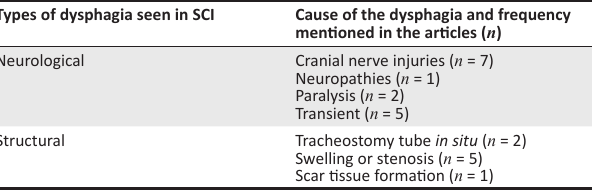
mentioned in the articles ( n ) Neuropathies ( n = 1) Paralysis ( n = 2) Transient ( n = 5) Swelling or stenosis ( n = 5) Scar tissue formation ( n = 1)